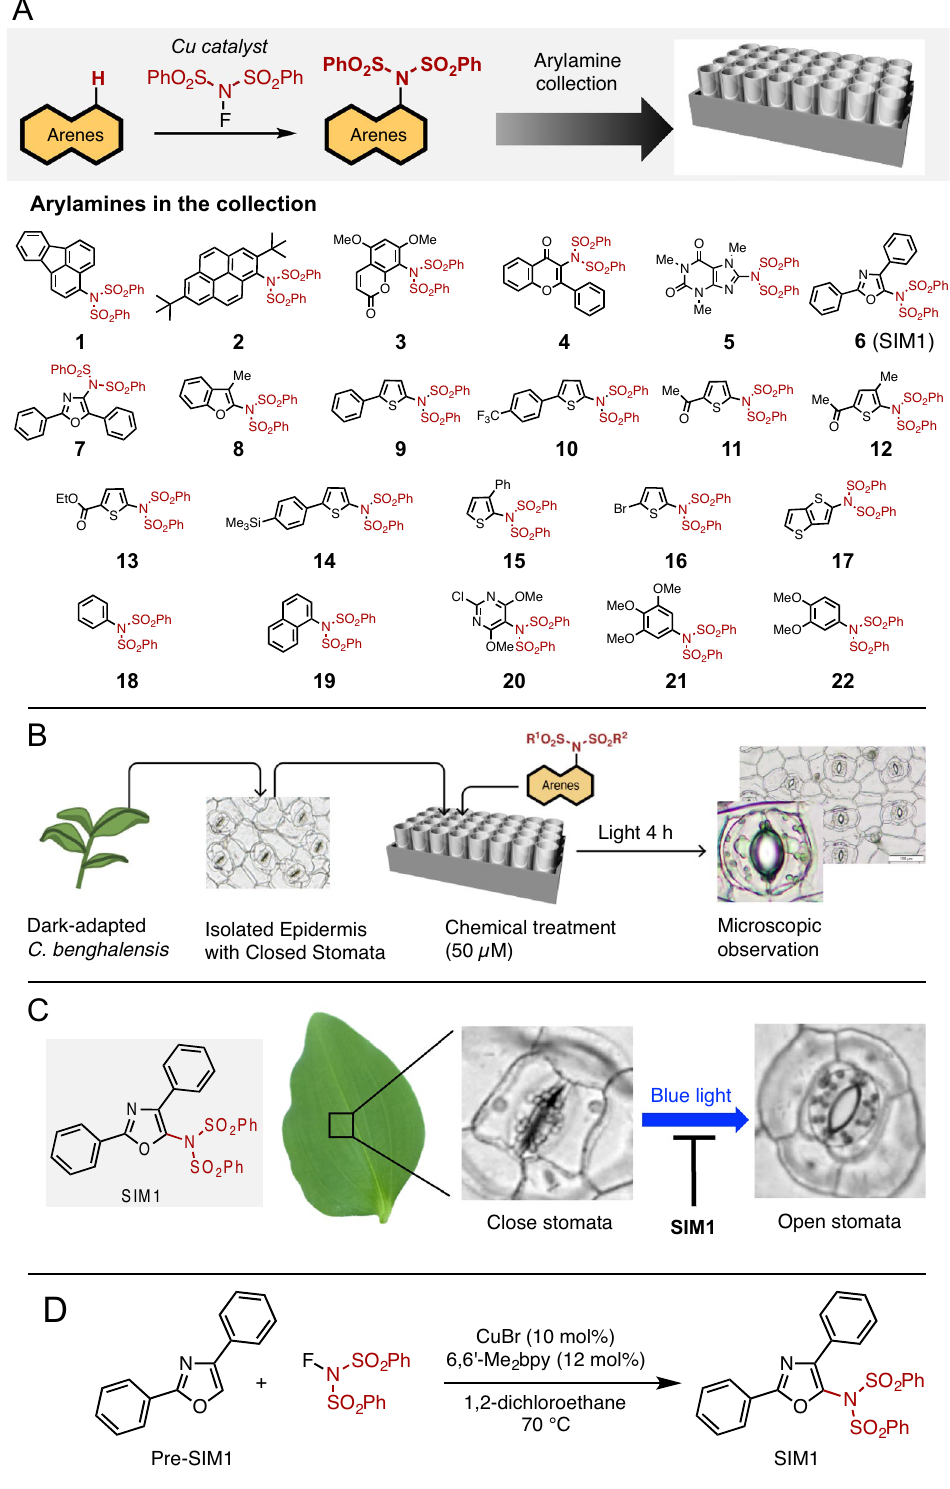
Figure 2. ( A ) Construction of arylamine collection. ( B ) Schematic illustration of the chemical screen of chemicals that inhibit stomatal opening. ( C ) Isolation of SIM1 as a stomatal regulating molecule. ( D ) Synthesis of